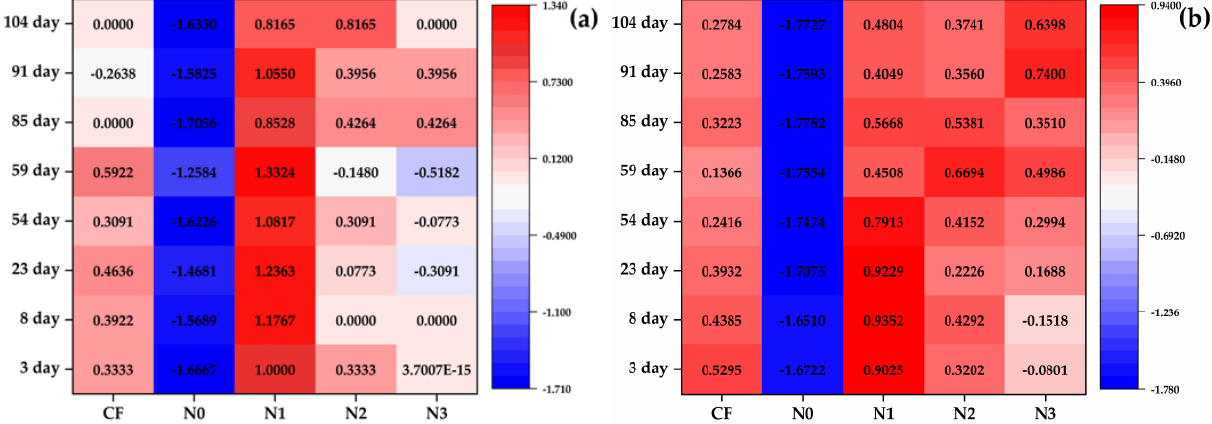
Figure 3. ( a ) Heat map analysis of soil β -glucosidase activity in different treatments, ( b ) Heat map analysis of soil catalase activity in different treatments.